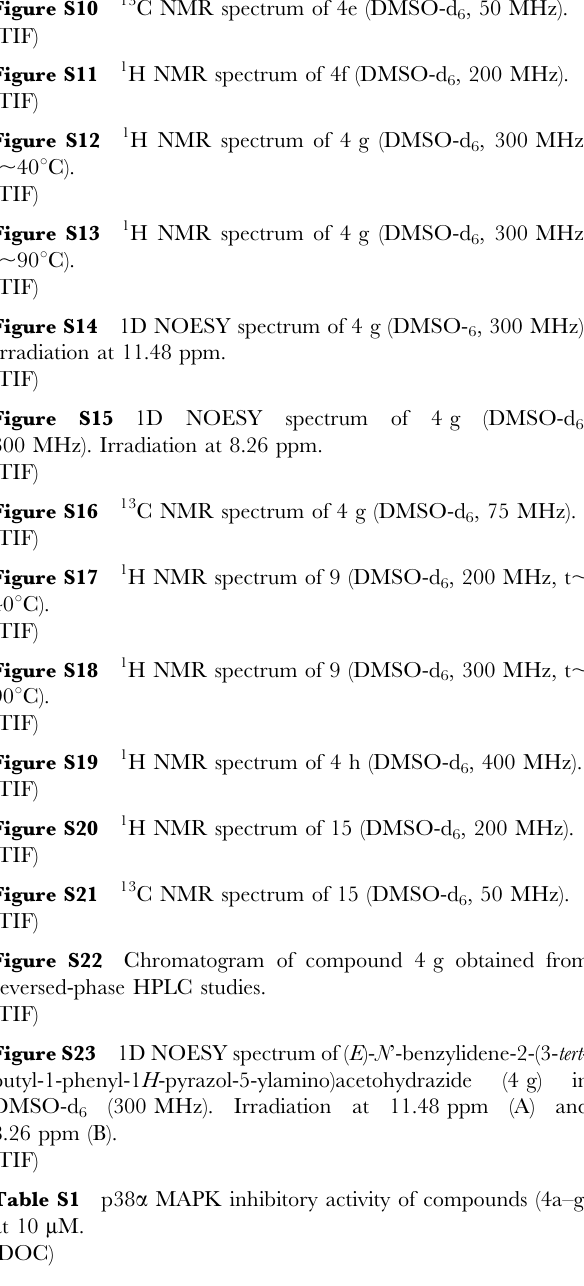
Figure S1 1 H NMR spectrum of 4a (DMSO-d 6 , 300 MHz). (TIF) Figure S2 13 C NMR spectrum of 4a (DMSO-d 6 , 75 MHz). (TIF) Figure S3 1 H NMR spectrum of 4b (DMSO-d 6 , 200 MHz). (TIF) Figure S4 13 C NMR spectrum of 4b (DMSO-d 6 , 50 MHz). (TIF) Figure S5 1 H NMR spectrum of 4c (DMSO-d 6 , 200 MHz). (TIF) Figure S6 13 C NMR spectrum of 4c (DMSO-d 6 , 50 MHz). (TIF) Figure S7 1 H NMR spectrum of 4d (DMSO-d 6 , 400 MHz). (TIF) Figure S8 13 C NMR spectrum of 4d (DMSO-d 6 , 100 MHz). (TIF)